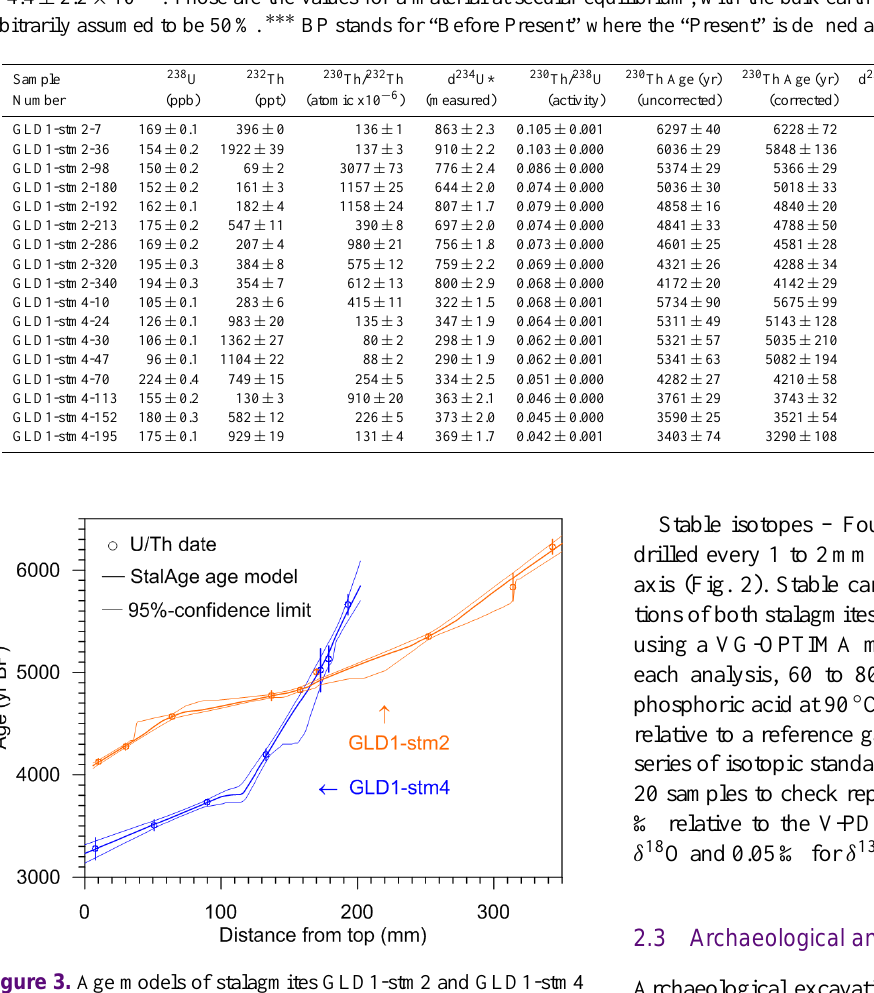
Table 1. U/Th dates from MC-ICP-MS analyses of stalagmites GLD1-stm2 and GLD1-stm4 from the Gueldaman GLD1 Cave. Analytical errors are 2 σ of the mean. U decay constants: λ 238 = 1.55125 × 10 − 10 (Jaffey et al., 1971) and λ 234 = 2.82206 × 10 − 6 (Cheng et al., 2013). Th decay constant: λ 230 = 9.1705 × 10 − 6 (Cheng et al., 2013). ∗ δ 234 U = ([ 234 U/ 238 U] activity – 1) × 1000. ∗∗ δ 234 U initial was calculated based on 230 Th age ( T ), i.e., δ 234 U initial = δ 234 U measured × e λ 234 × T . Corrected 230 Th ages assume the initial 230 Th/ 232 Th atomic ratio